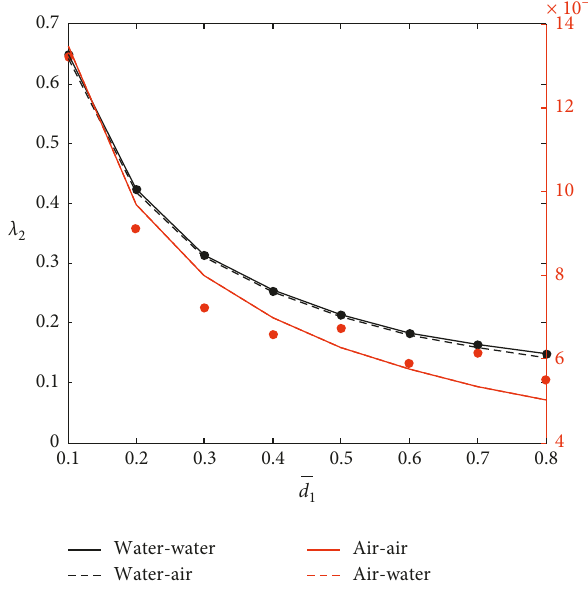
Figure 24: The peak pressures of P thicknesses. The water-backed case is plotted in the left axis, and the air-backed case is plotted in the right axis. Table 8: The equivalent charge mass for the inner shell with different outer shell thicknesses. Case Water-water ( m